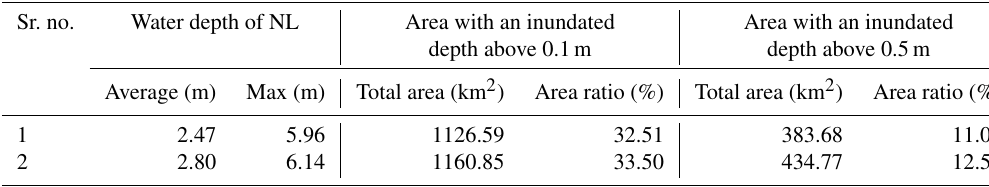
Table 3. Results of waterlogging in the lakeside area of NL. Sr. no.